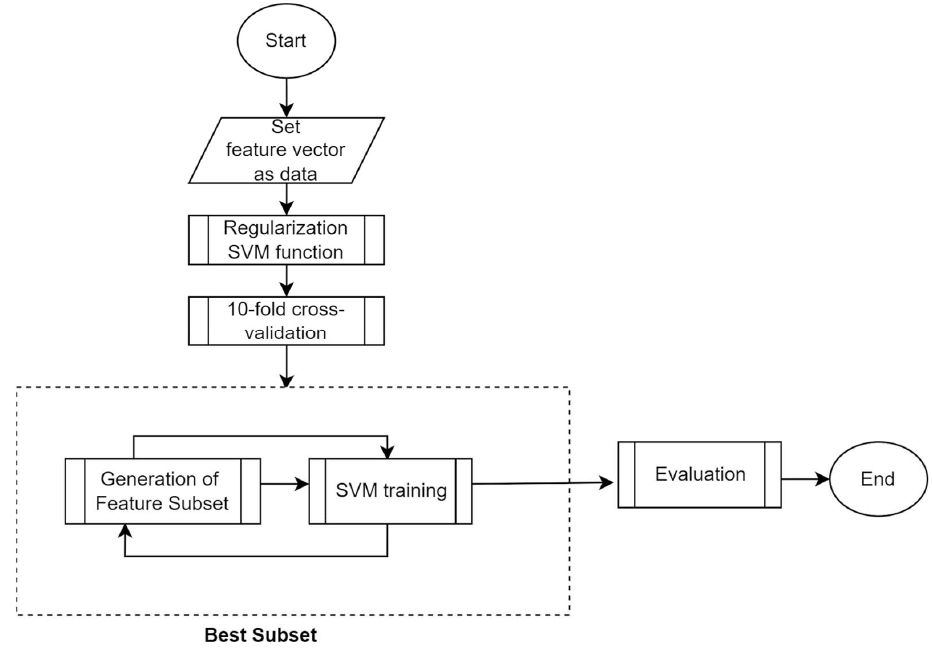
Figure 2. RbFS block diagram.